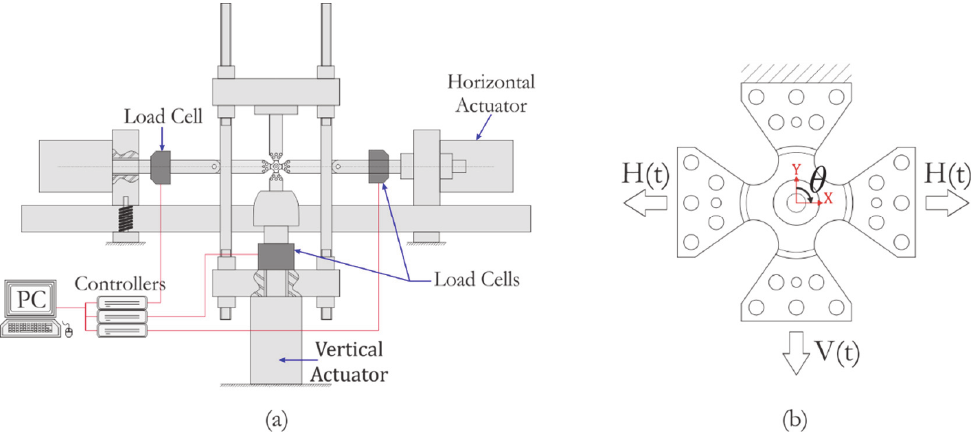
Figure 1: (a) Biaxial test rig. (b) Cruciform specimen, applied loads and definition of θ , positive clockwise. Load